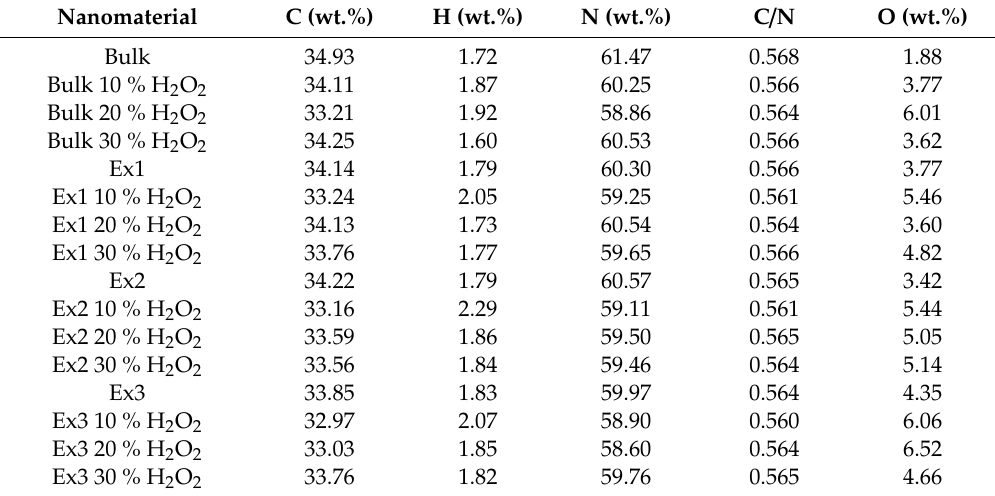
Table 1. Elemental analysis of graphitic carbon nitride (GCN) nanomaterials.